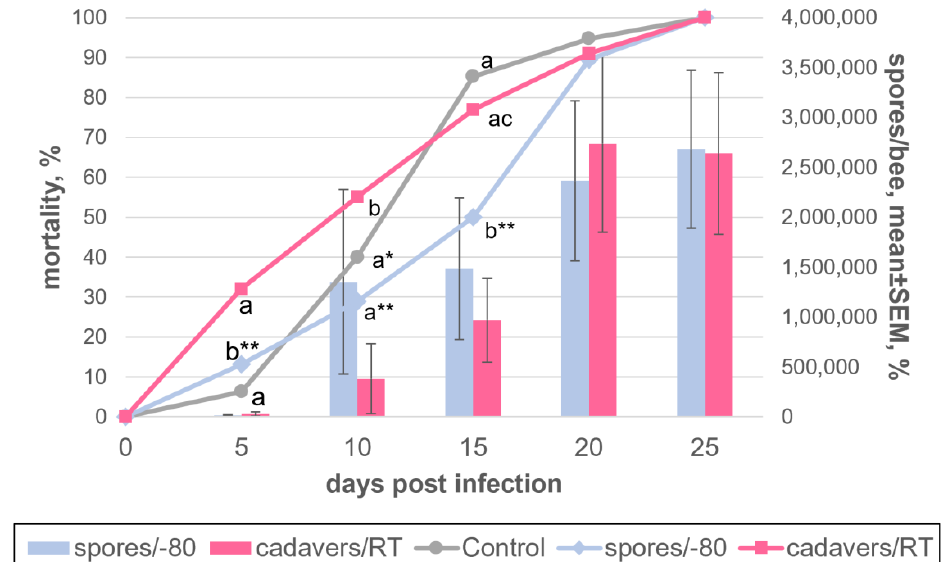
Figure 4. Dynamics of Vairimorpha ceranae development in honey bee adults, maintained at 25 ◦ C and experimentally infected with 1 million spores/bee. Spores were either isolated from dried honey bee cadavers stored at room temperature (“cadavers/RT”) or isolated from live bees and frozen at − 80 ◦ C (“spores/ − 80”) prior to the experiments. The indications are as in Figure 2. The data which this scheme was created from are found in Table S3.